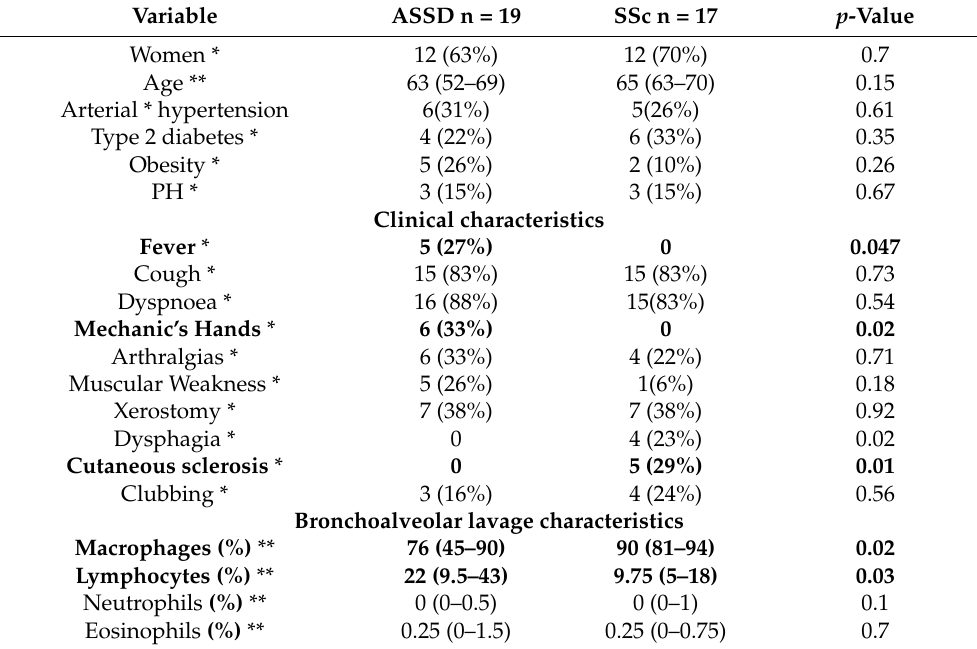
Table 1. General description of the recruited